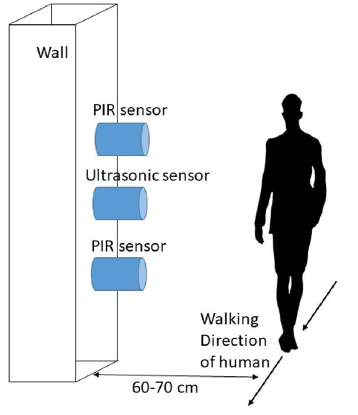
Figure 9. Direction of motion of human being during experiment